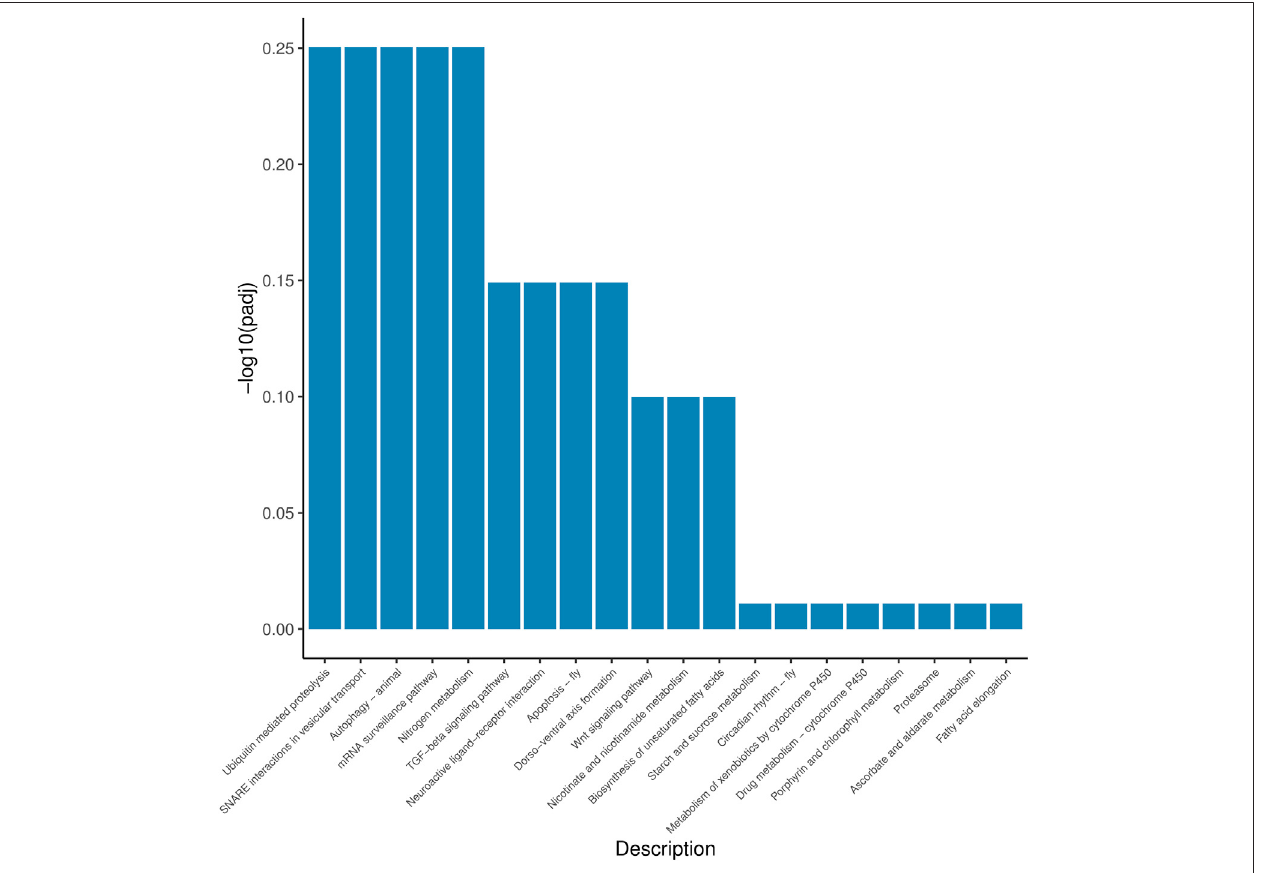
FIGURE 2 | KEGG enrichment analysis of salt-alkali tolerance candidate